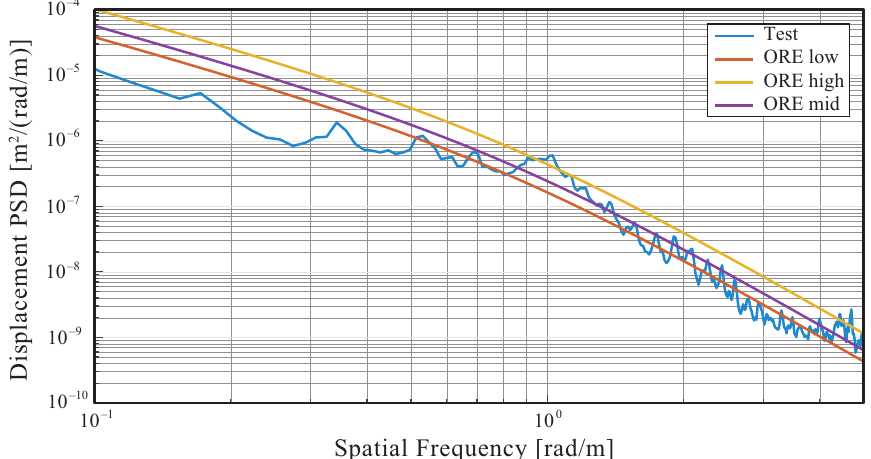
Figure 2. Track power spectral density (PSD). Integrating S ¨ w of Equation (14) into the range of relevant frequencies yields the w ] ), from which comfort indexes are readily mean squared weighted acceleration ( E [ ¨ w 2 w (cid:112) ] (note that this definition makes the index decrease E [ ¨ w 2 calculated (see [11]) as c I = 6 w as comfort improves). The comfort filter H c strongly attenuates frequencies above 30